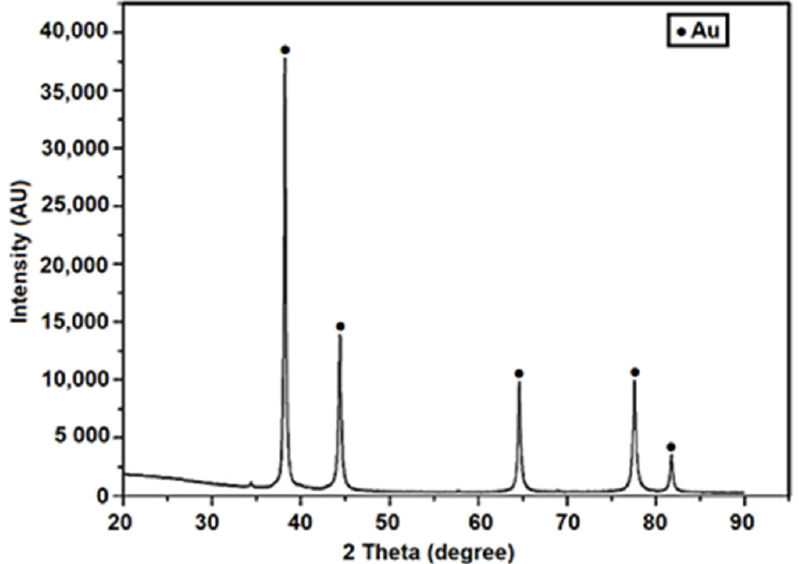
Figure 11. XRD pa tt ern of the produced gold powder. Figure 11. XRD pattern of the produced gold powder.